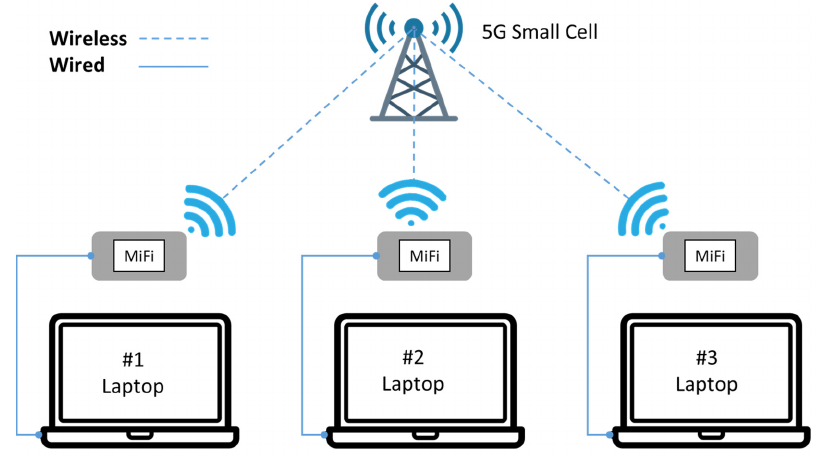
Figure 4. Schematic of the laptops, MiFi, and 5G small cell connection.